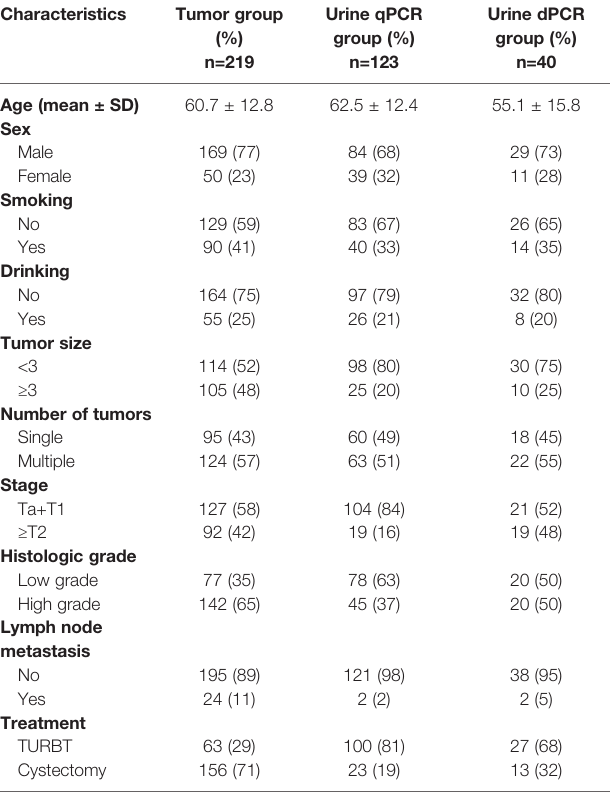
TABLE 1 | Clinicopathological characteristics of bladder cancer